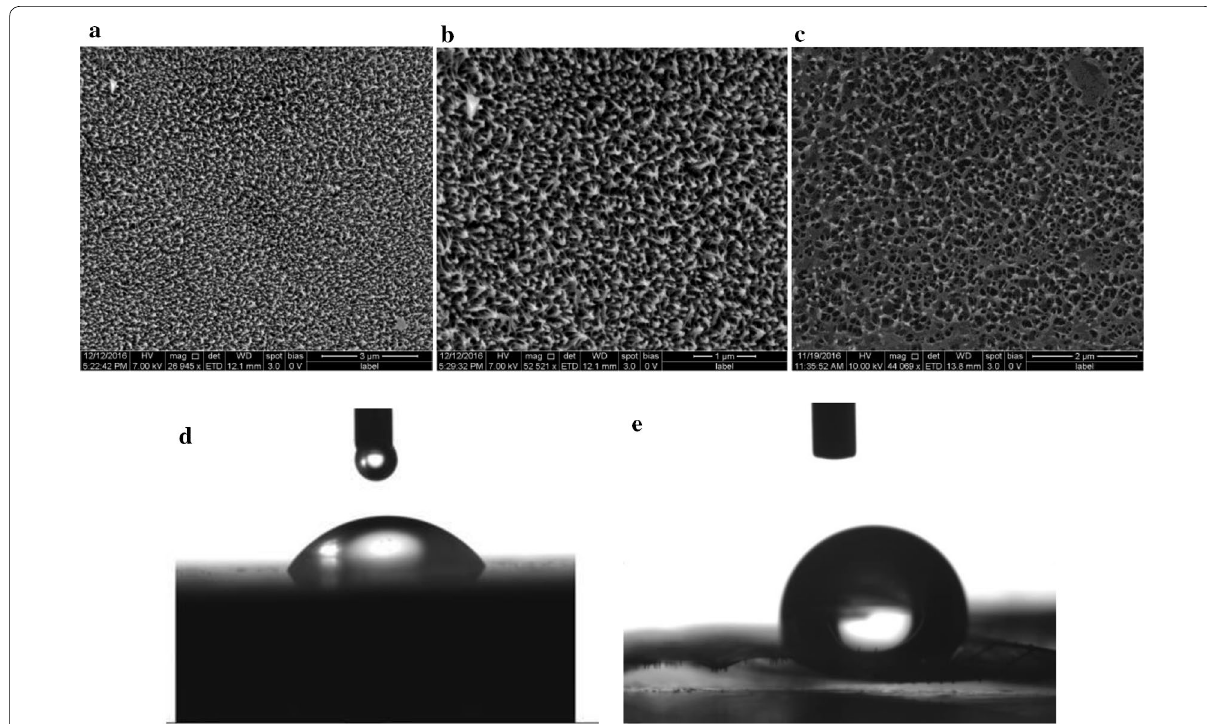
Fig. 1 a FESEM images of the dragonfly wings showing the nanopillar architecture. b Tilted view showing the peaks that were approximately 188 nm tall and, clustering of the peak tips was observed. c Top view—distance between the peaks ranged from 88 nm to 157 nm, due to clustering of peak tips. Water Contact angle of the glass cover slip 57.3° ( d ) and P. flavescens wing 124° ( e ) obtained using KRUSS drop shape Analyzer